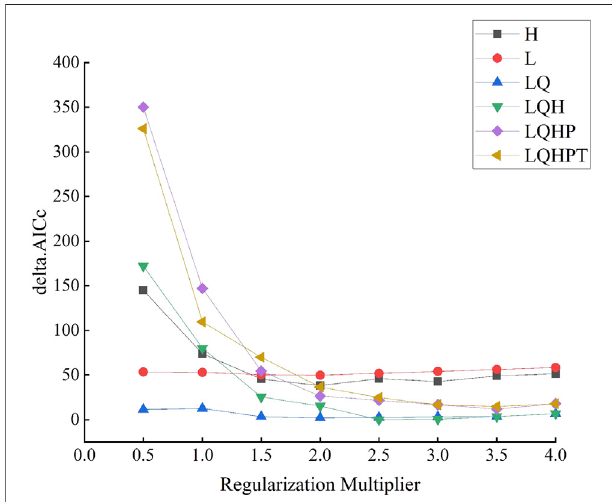
FIGURE 1 | Assessment metrics of MaxEnt generated by